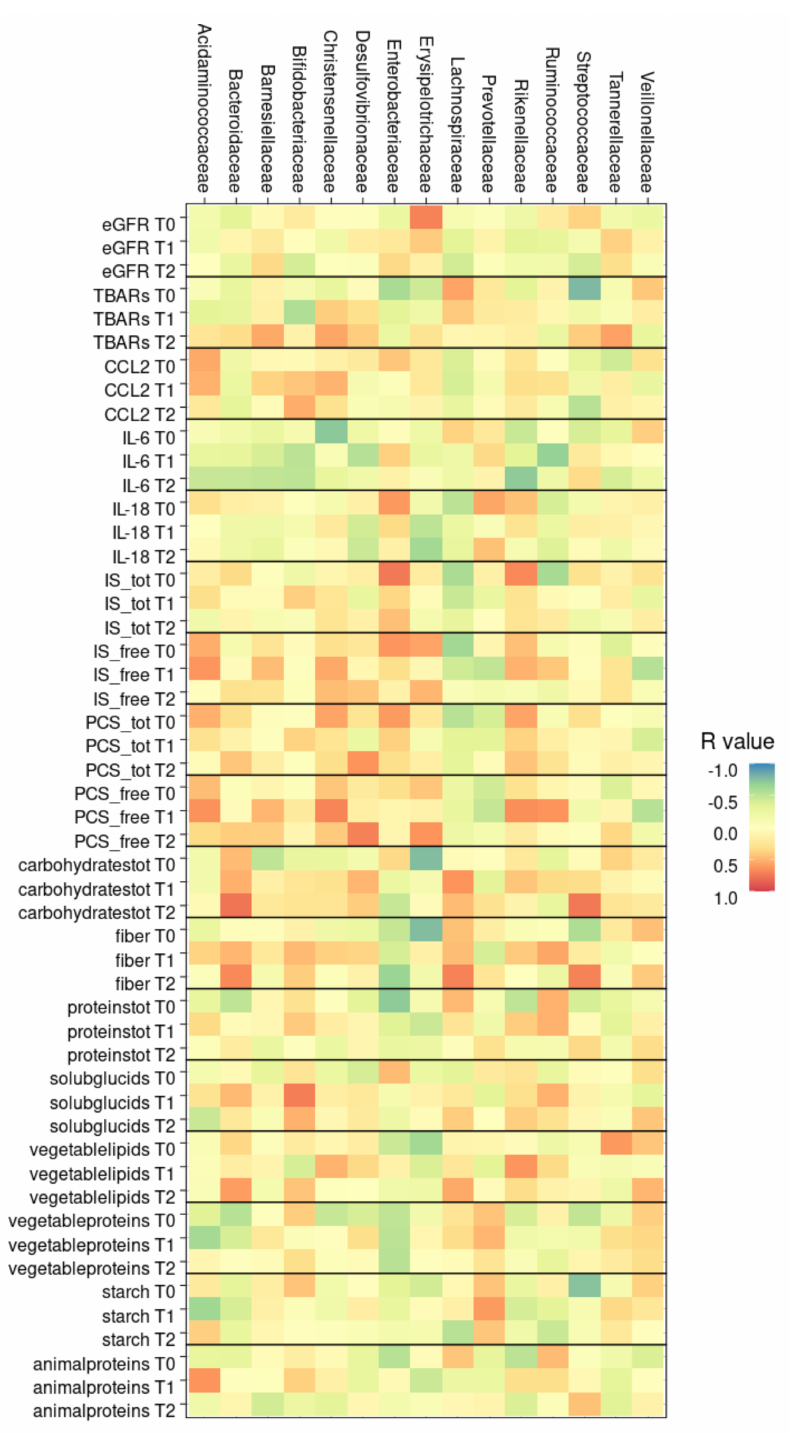
Figure 9. Co-abundant analysis of the main bacterial families and clinical parameters. Co-abundances have been elaborated through Spearman correlation and are shown as R values reporting co-absence (blue) of bacterial and clinical parameter abundances; co-presence of both